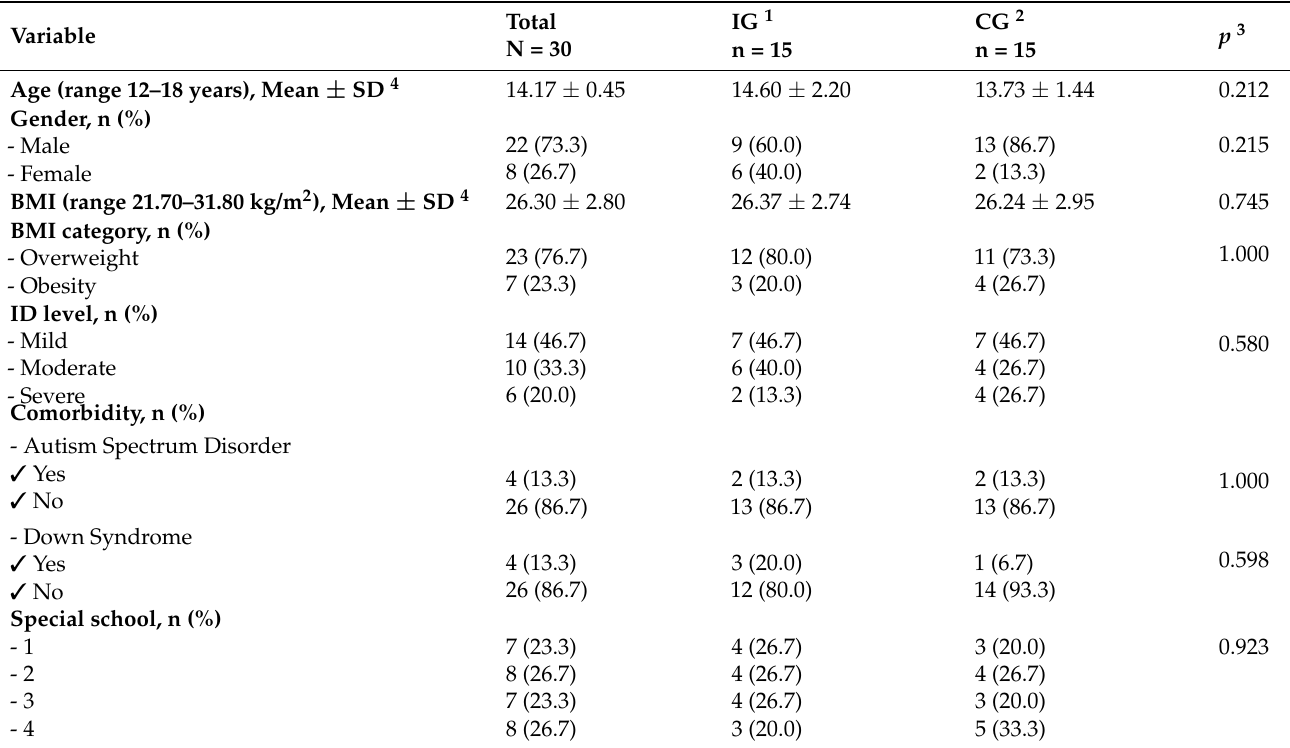
Table 2. Participant characteristics at